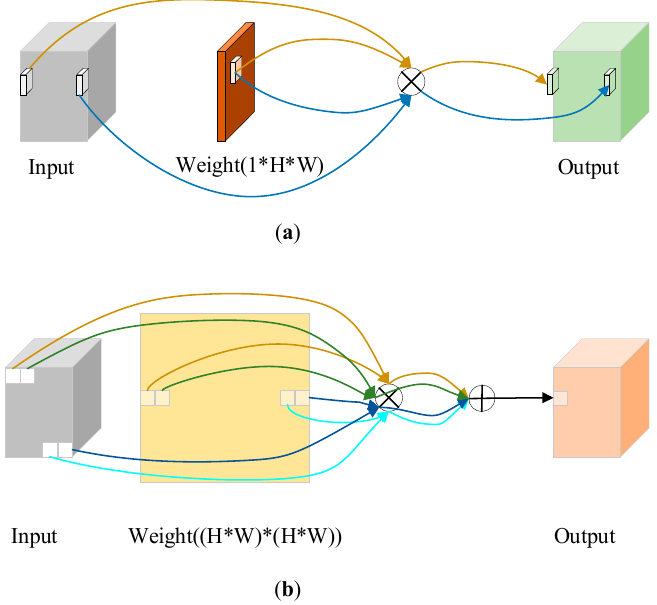
Figure 4. The different correlations between output and input based on two different spatial attention methods. ( a ) shows the correlations based on Figure 3a; ( b ) shows the correlations based on Figure 3b. The lines with same color represent a pair of input and weight.